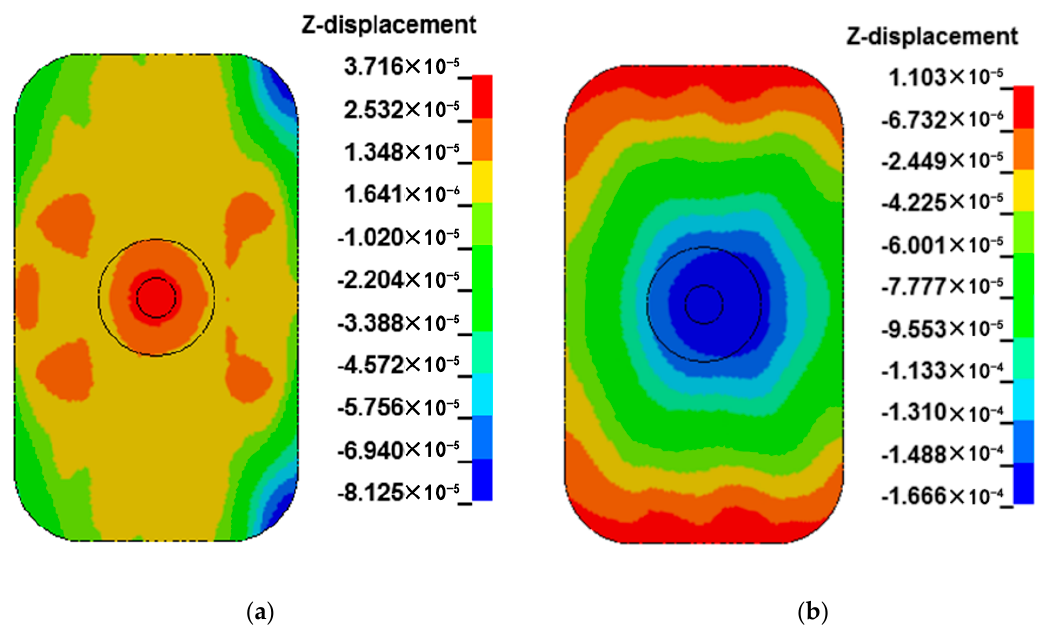
Figure 13. Schematic diagram of plate deformation. ( a ) plate deformation distribution at the upper half cycle maximum. ( b ) plate deformation distribution at the lower half cycle maximum.